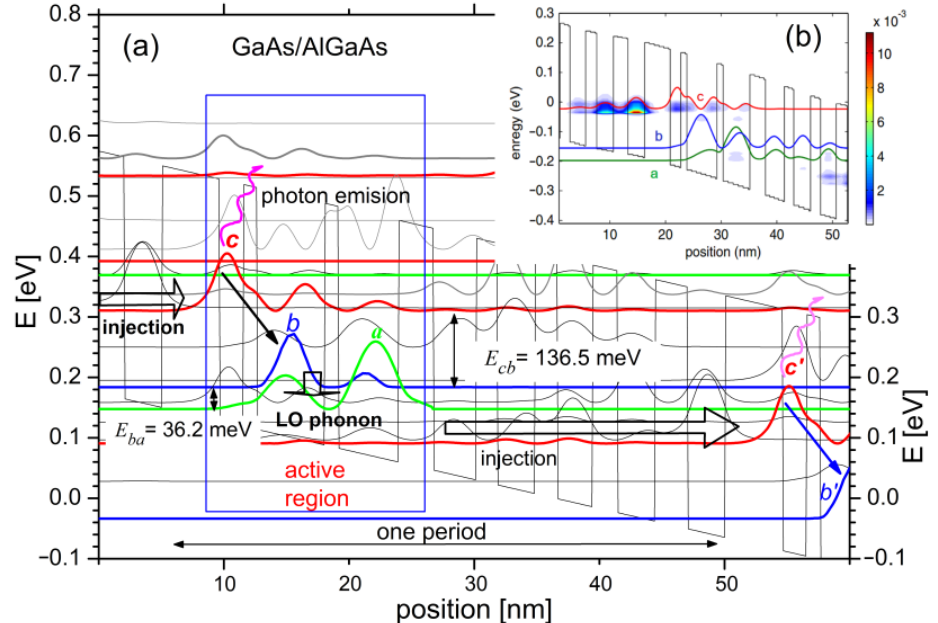
Figure 2. QCL operation presented: ( a ) basic electron transitions within the polarised laser struc- ture calculated with FMSL model; ( b ) electron concentration distribution for a single QCL period determined with RSM model.